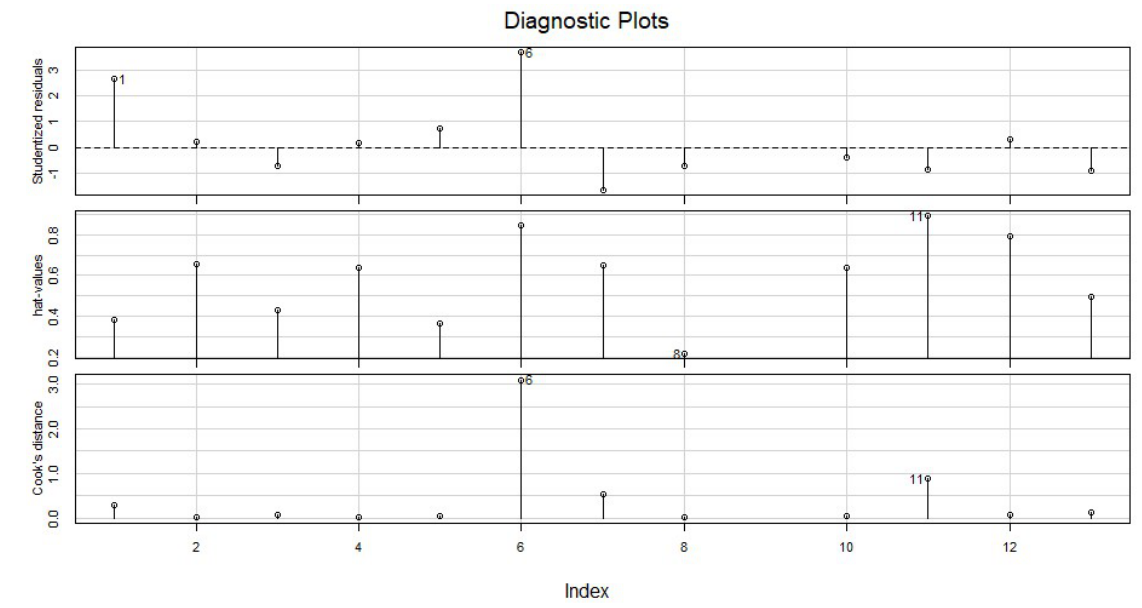
Figure 7. Diagnostic